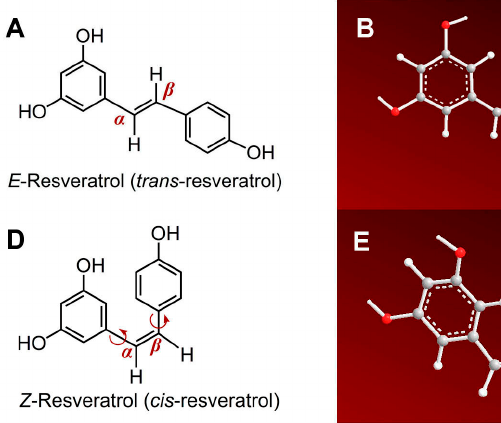
Figure 1. The configuration formula and molecular models of two resveratrols: ( A ) configuration formula of E -resveratrol; ( B ) preferential conformation-based ball-and-stick model of E -resveratrol (front view); ( C ) preferential conformation-based ball-and-stick model of E -resveratrol (right view); ( D ) configuration formula of Z -resveratrol; ( E ) preferential conformation-based ball-and-stick model of Z -resveratrol (front view); ( F ) preferential conformation-based ball-and-stick model of Z -resveratrol (right view). (The preferential conformation was created using ChemBioOffice 2014/Chem3D Pro.)